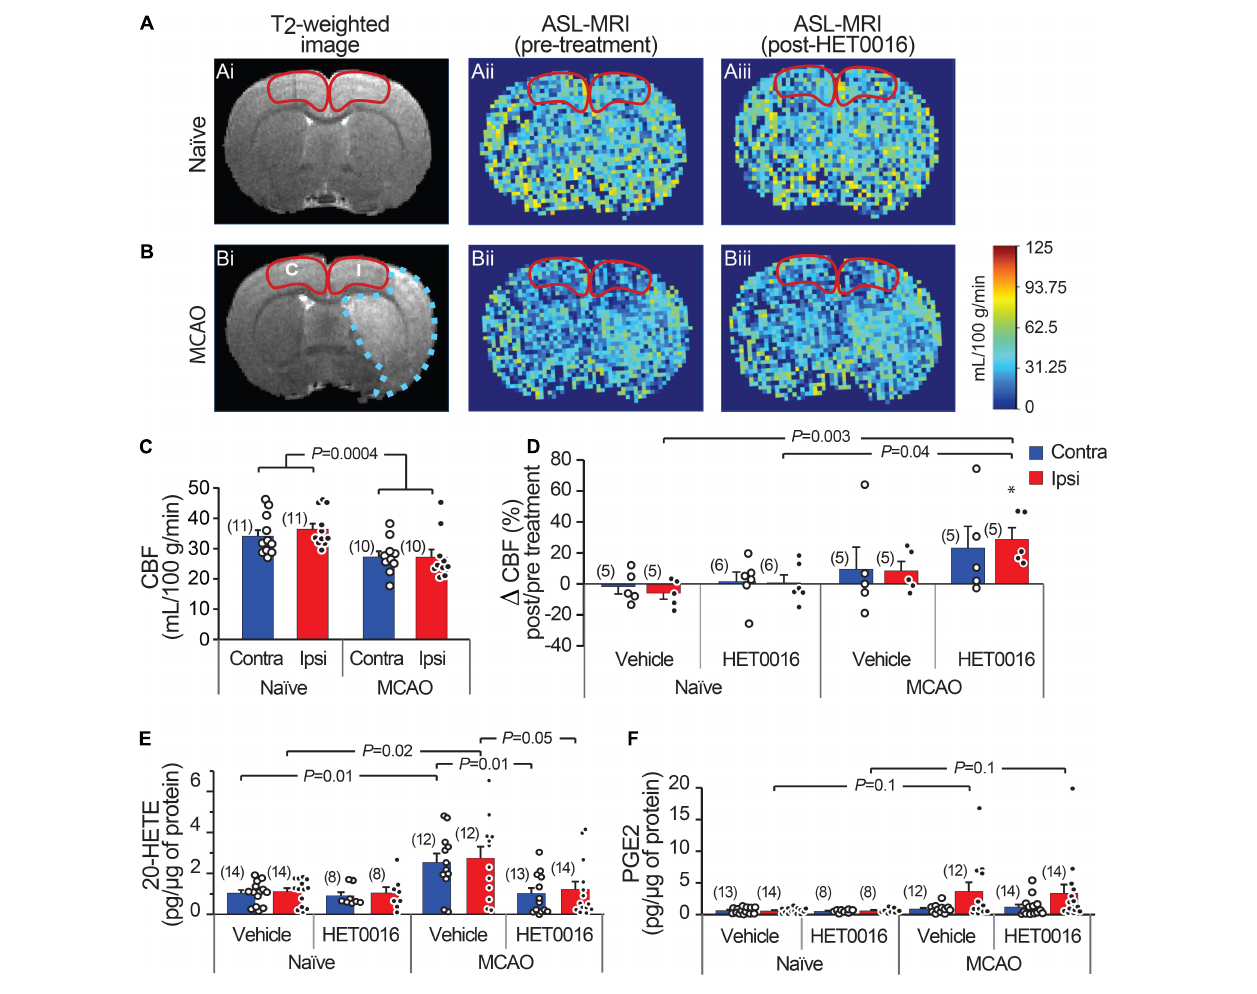
FIGURE 5 | Increased 20-HETE synthesis reduces resting CBF in the stroke peri-infarct. (A,B) T 2 -weighted MRI (left; Ai and Bi) and ASL images of CBF before (center; Aii and Bii) and after (right; Aiii and Biii) HET0016 injection in naïve and MCAO rats. CBF was quantified in the cortical regions outlined in red (I, ipsilateral peri-infarct; C, contralateral). (C) Cortical CBF is reduced bilaterally in MCAO animals compared to naïve animals. (D) HET0016 (1 mg/g i.v.) increases CBF significantly in the MCAO Ipsi peri-infarct region without altering CBF in naïve brains. (E,F) Mass spectrometric measurement of 20-HETE and PGE2 in microdissected cortical tissue (region marked in A,B ), normalized to total protein. (E) 20-HETE is increased in both contralateral and ipsilateral cortices of MCAO rats and treatment with HET0016 reduces it to baseline levels comparable to naïve rats. (F) Cortical PGE2 levels are not changed significantly after MCAO and are not altered by HET0016 treatment. P -value in (C) was obtained from a two-way ANOVA. P -value in (D–F) was obtained from ANOVA followed by Tukey’s HSD. *indicates significantly different compared to zero change from baseline obtained from a one-sample T -test. Number in parentheses above each bar indicates N